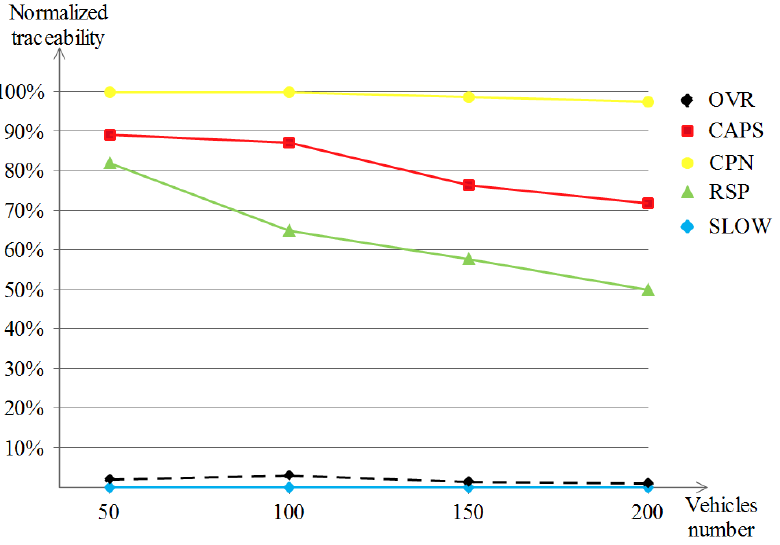
Figure 10. Normalized-traceability of privacy schemes in the Manhattan scenario.